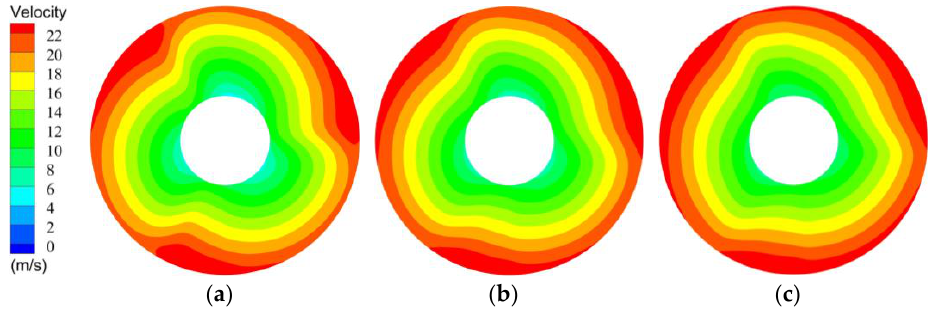
Figure 8. Velocity distribution of impeller inlet: ( a ) Q = 0.8 Q bep ; ( b ) Q = 1.0 Q bep ; ( c ) Q = 1.2 Q bep .